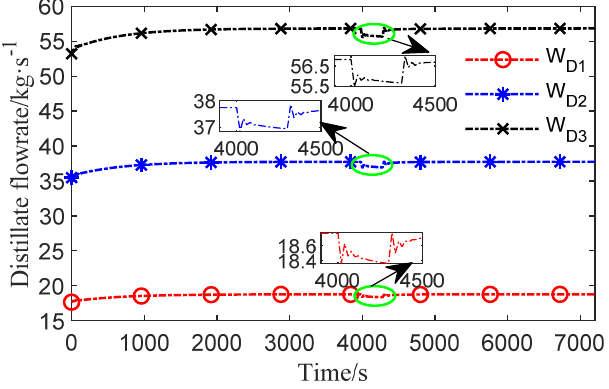
also decreases first and then increases. Figure 20. Dynamic of T B 1 , T B 2 , T B 3 for step increase in C F . Figure 20. Dynamic of for step increase in